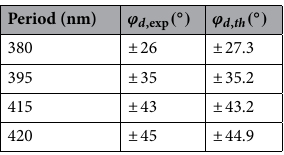
Table 1. Diffracted experimental and theoretical in plane angles as a function of the grating period.